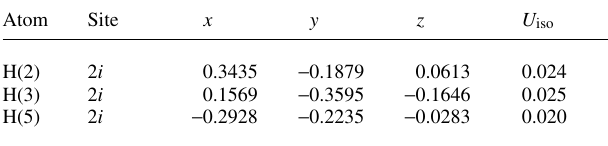
Table 2. Atomic coordinates and displacement parameters (in Å 2 ) .